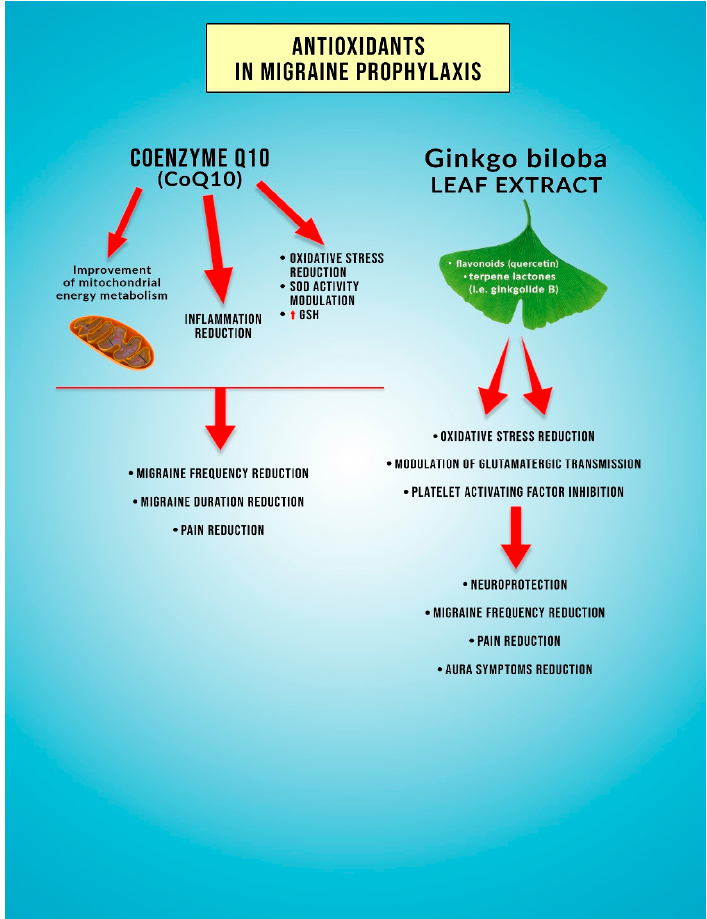
Figure 2. Influence of coenzyme Q10 and Ginkgo biloba leaf extract antioxidant on red-ox status parameters in patients with migraine.